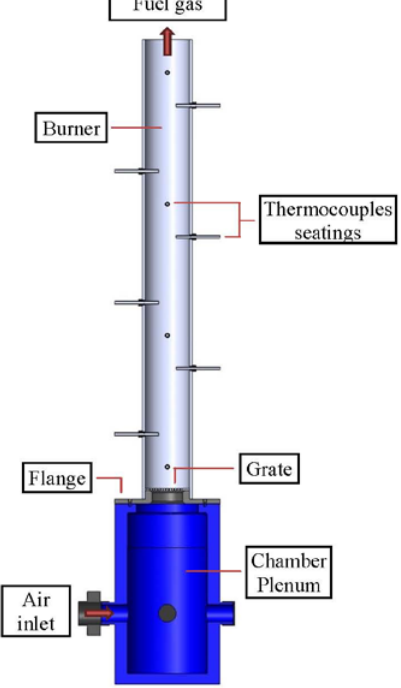
Figure 1. Working module computer-aided design (CAD) scheme.